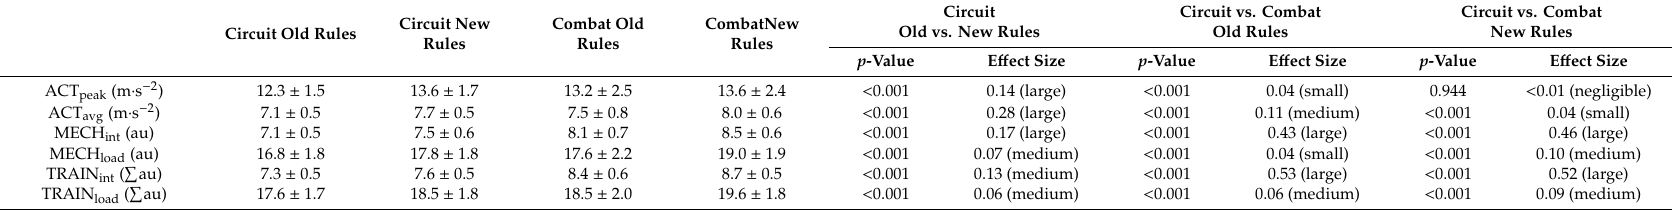
Table 6. Kinematic response to taekwondo training and combat—comparison between old and new